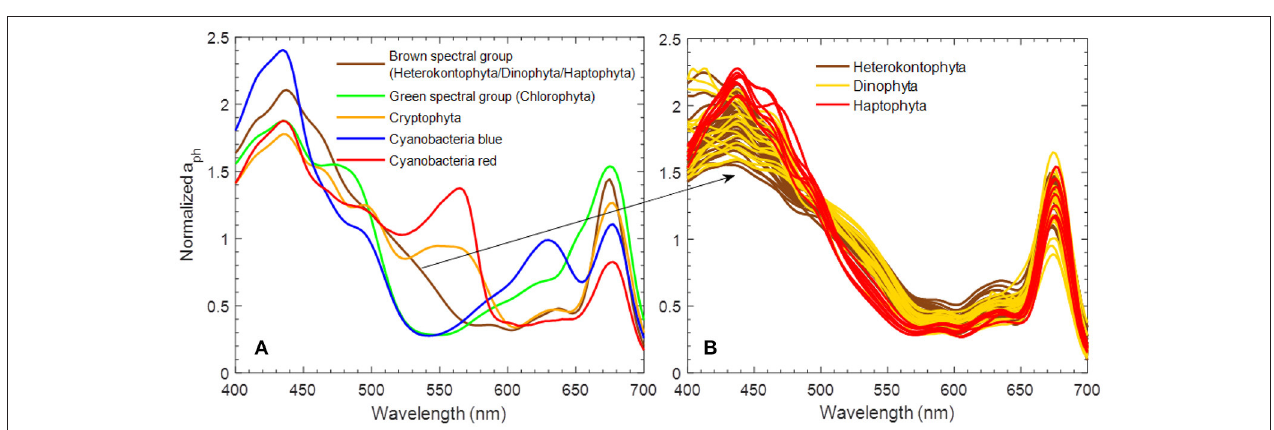
FIGURE 1 | (A) Five area-normalized absorption spectra of phytoplankton used in R rs ( λ ) simulation for the C2X database, and (B) corresponding spectra of cultures representing the “brown spectral group.”